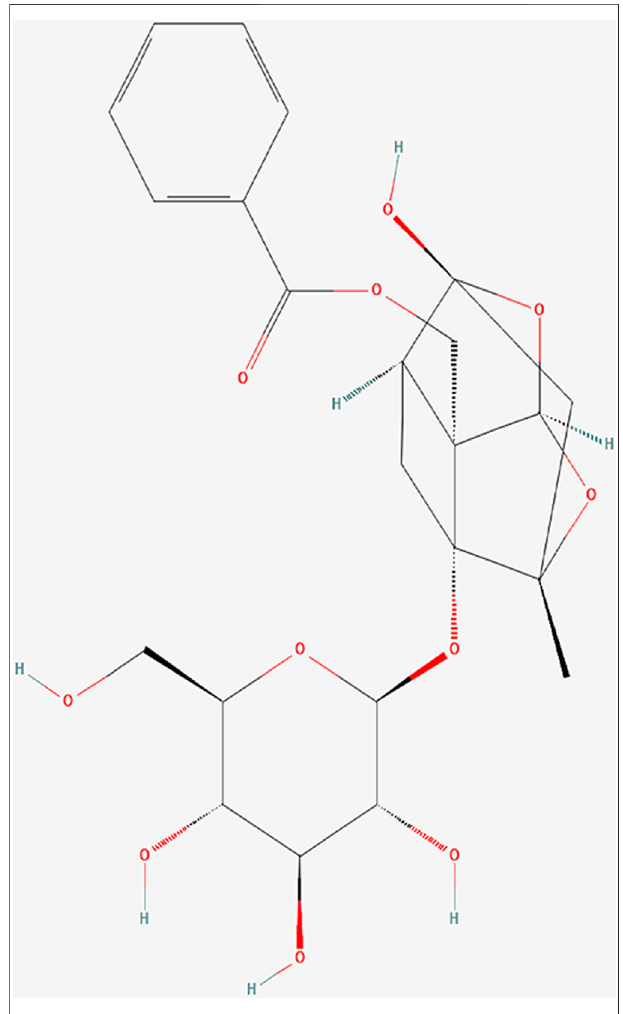
FIGURE 1 | PubChem identi fi er: Paeoni fl